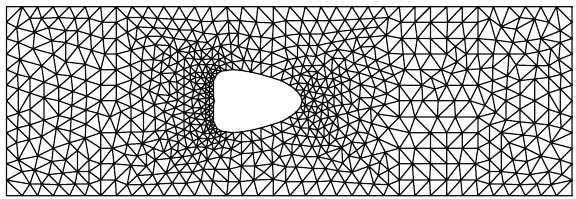
Figure 2: Case 2: finite element mesh for the target curve.